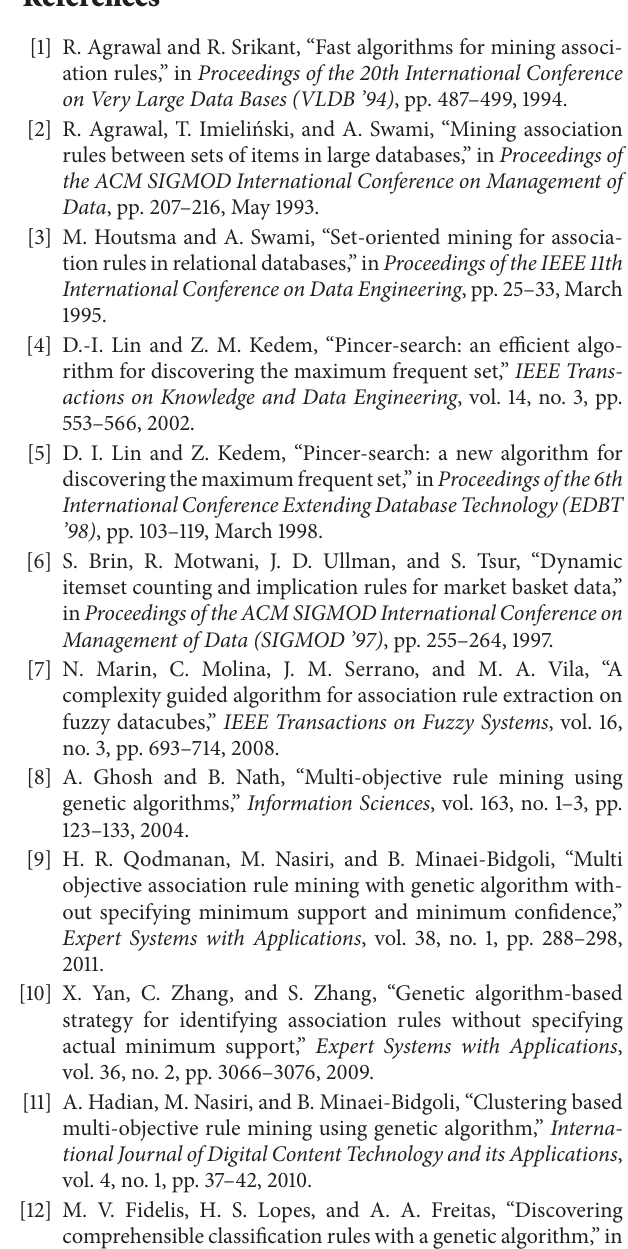
Table 6: The averages of several results for ARMMEA.